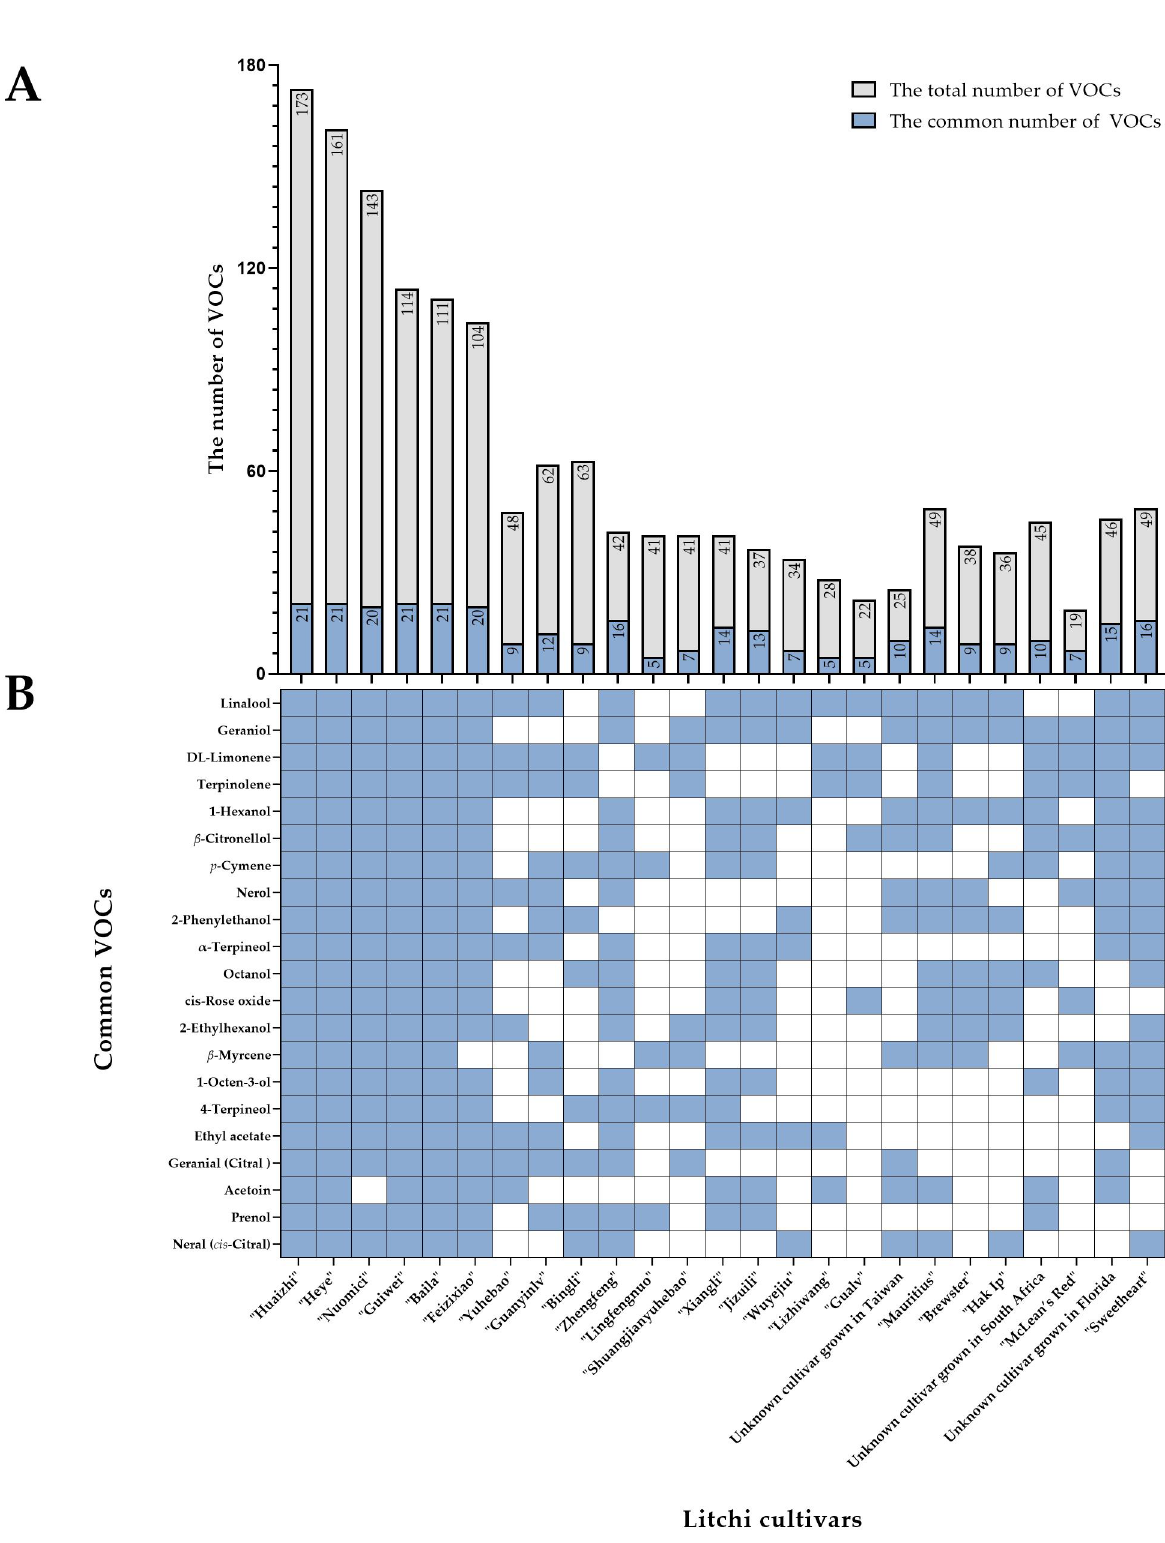
Figure 1. The number of VOCs in different litchi cultivars. ( A ) The number of common VOCs in different litchi cultivars. ( B ) The presence and absence of common VOCs in different litchi cultivars. The blue squares indicate the presence of a VOC, and the white squares indicate the absence of a